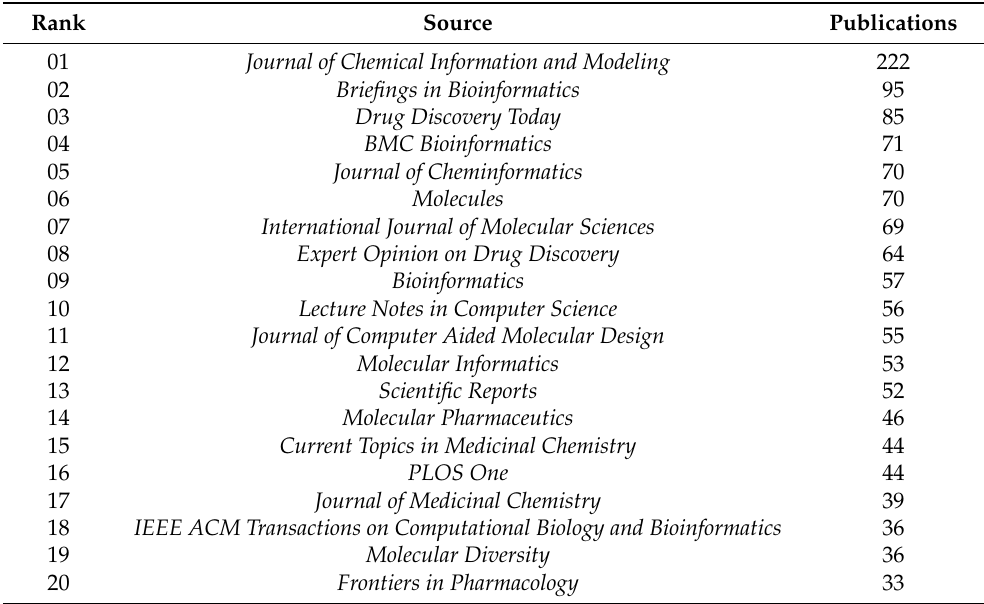
Table 3. Overview of the sources with the most publications.